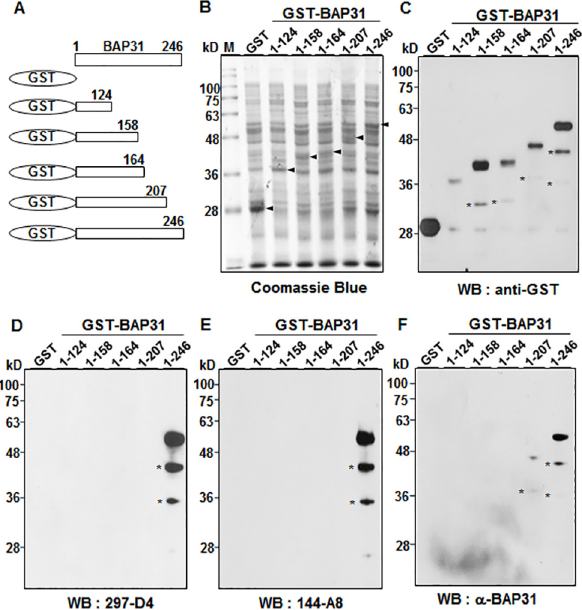
Fig 2. Epitope mapping of 297-D4, 144-A8, and α -BAP31 antibodies. (A) Schematic diagram of recombinant BAP31 fragments (residues 1 – 124, 1 – 158, 1 – 164, 1 – 207, and 1 – 246) used in this study. (B) Individual fusion proteins were expressed in bacteria as fusion proteins with GST tag at the N-terminus and stained with Coomassie brilliant blue after SDS-PAGE. (C-F) Western blot analysis of GST-BAP31 fusion proteins with anti-GST (C), 297-D4 (D), 144-A8 (E), and α -BAP31 (F) antibodies. The asterisks indicate partial degradation products of GST-BAP31 fusion